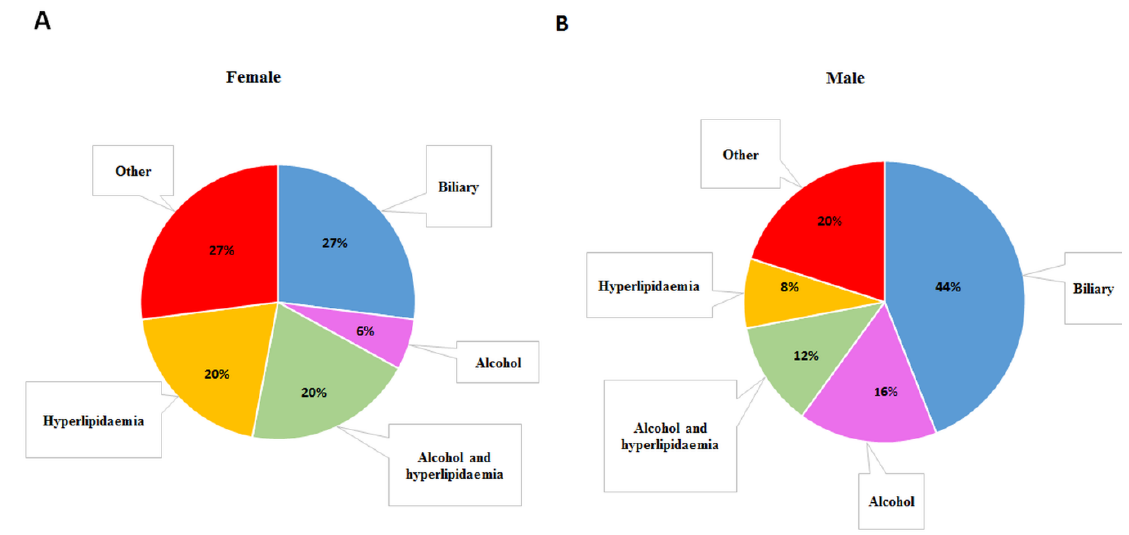
Figure 1. Etiology of acute pancreatitis in the group of ( A ) women and ( B )